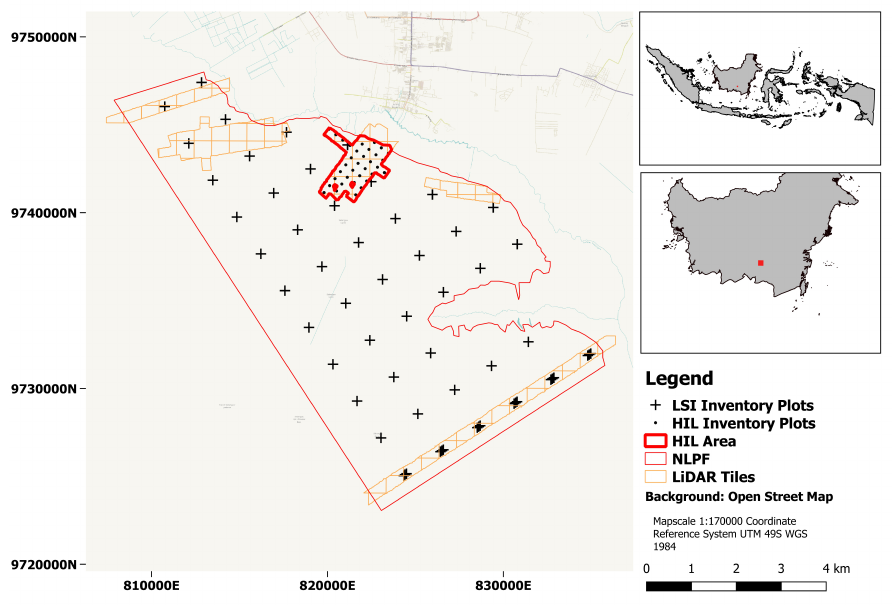
Figure 1. Location of the study area, the ALS tiles and the two systematic sampling grids: (i) High Intensity LiDAR (HIL) and (ii) Large Scale Inventory (LSI). All plots that are covered by LiDAR tiles were used as ALS training